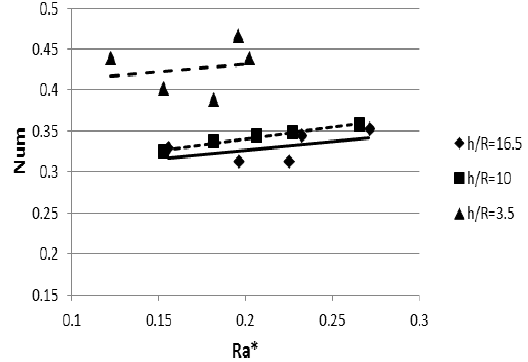
Figure 15. Mean Nu versus Ra * with different depth/radius ratios. Table 2. The correlation equations